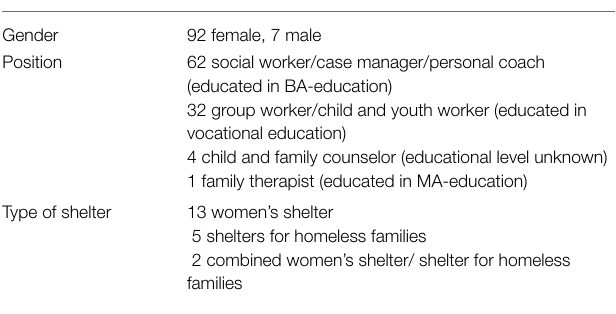
TABLE 2 | Participant